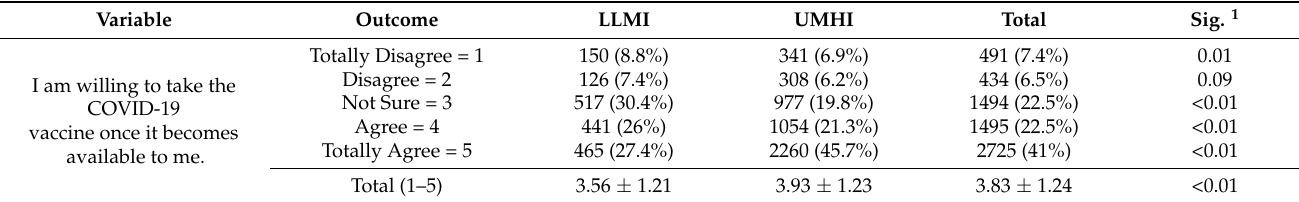
Table 4. Dental students’ attitudes towards the COVID-19 vaccine stratified by economic level, February 2021. Variable Outcome LLMI UMHI Total Sig.